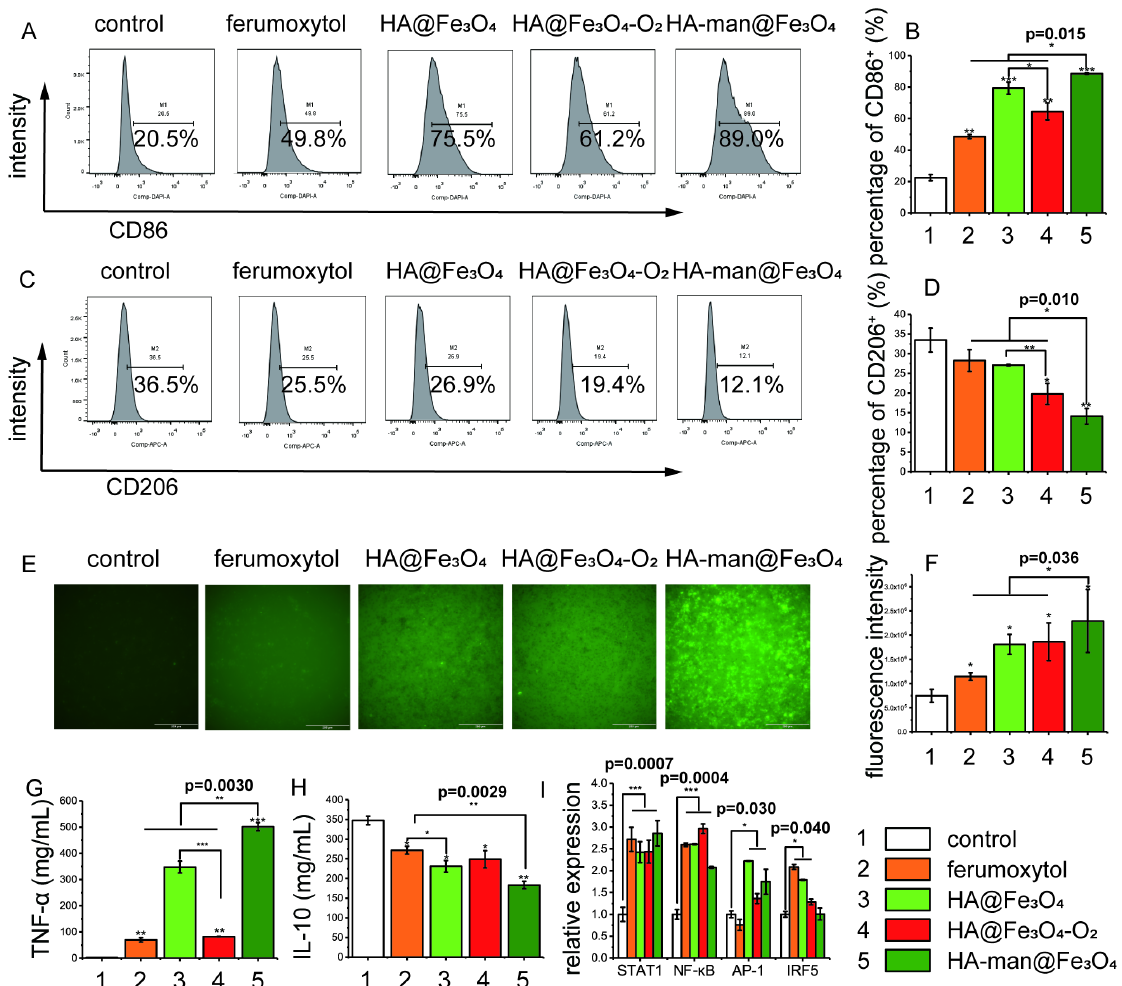
Figure 3. RAW 264.7 cell polarization in vitro. ( A , B ) Flow cytometry analysis of the